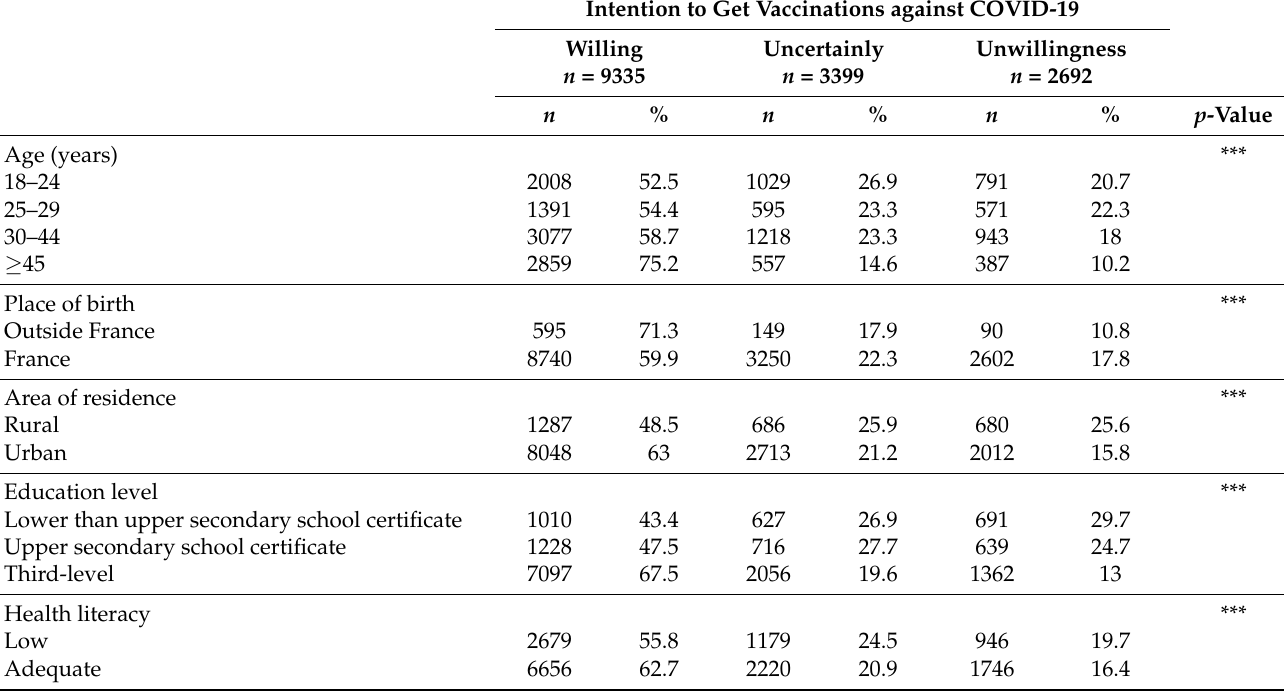
Table 2. Univariate analyses of factors associated with intention to vaccinate against COVID-19 ( n =